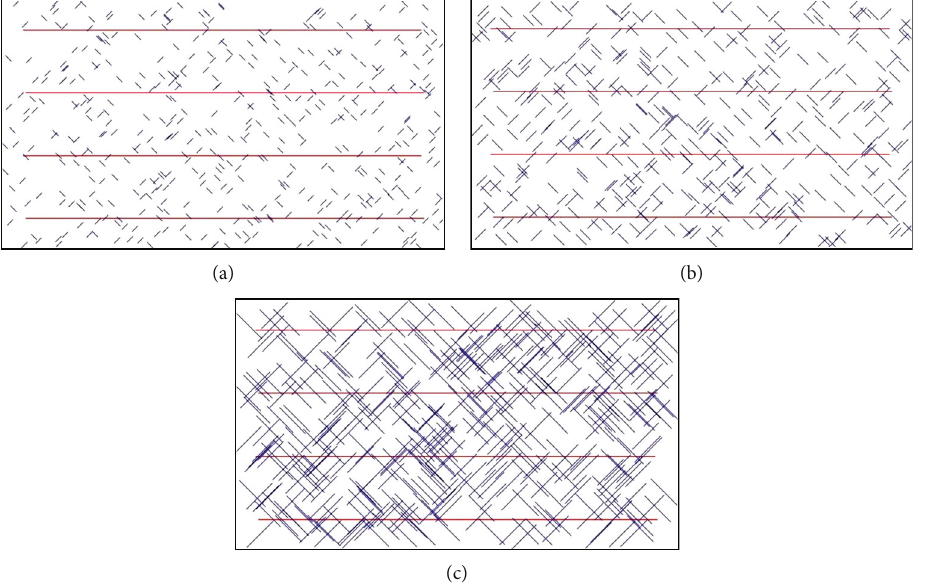
Figure 6: Di ff erent lengths of natural fractures under the constant number considered in the well spacing optimization: (a) minimal length, (b) P50 length, and (c) maximum